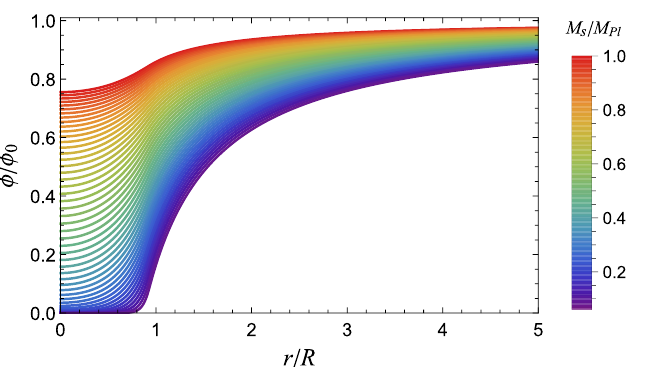
Figure 2. Scalar field profile, rescaled by its asymptotic value ( φ 0 = M 2 s / M Pl ), as a function of the radial coordinate, for values of M s / M Pl ranging from 0.06 to 1. In all cases, the central number density of the SNS was fixed to 0.476 fm − 3 , which, in GR, yields a 1.4 M (cid:12) equilibrium model for the ENG EOS used in this work. The masses of SNSs monotonically increase from 0.595 M (cid:12) when M s = M Pl to 1.3999 M (cid:12) when M s = 0.06 M Pl . For this plot, the quadratic variant of the symmetron model was considered, cf. Equation (7), but the same qualitative conclusions also apply to Equation